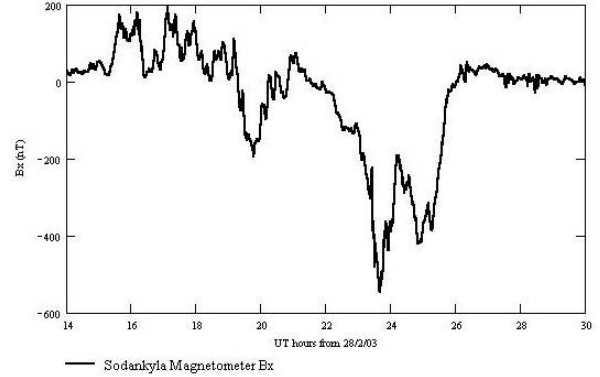
Fig. 9. IMAGE magnetometer traces showing the B x component on the night of 28 February–1 March 2003 at